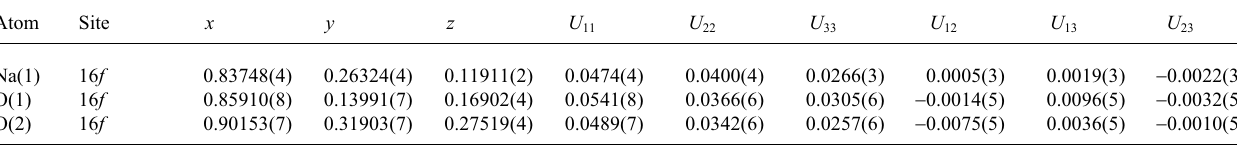
Table 3. Atomic coordinates and displacement parameters (in Å 2 ).